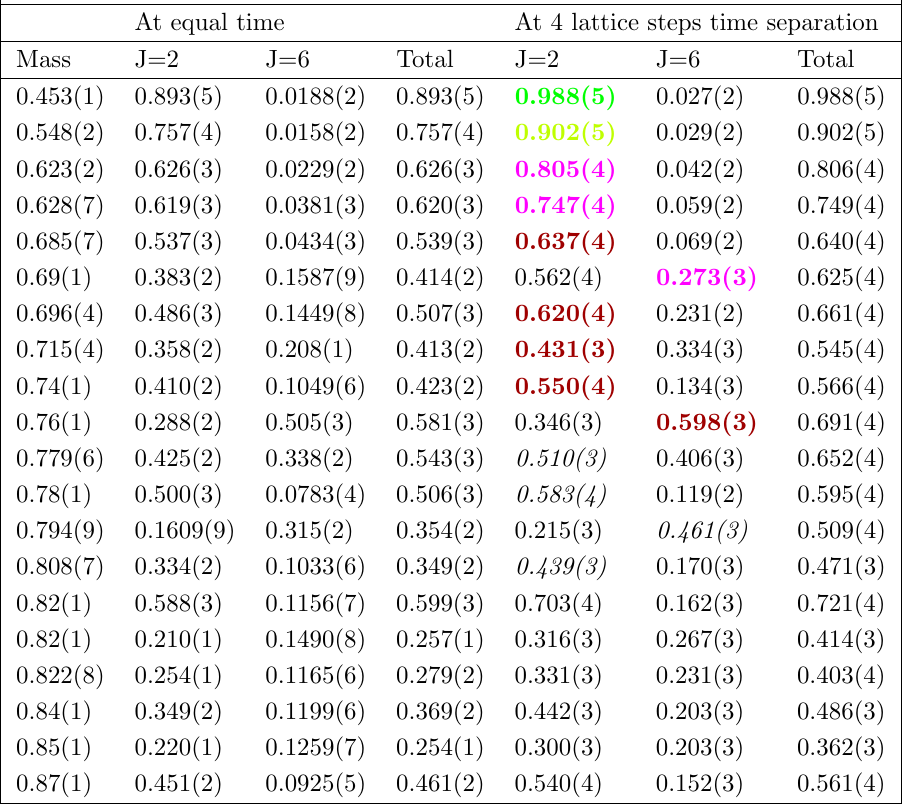
Table 17. Masses from glueballs in A 3 and A 4 representations with C = + and averaged over P , using conventional operators and overlaps with AR